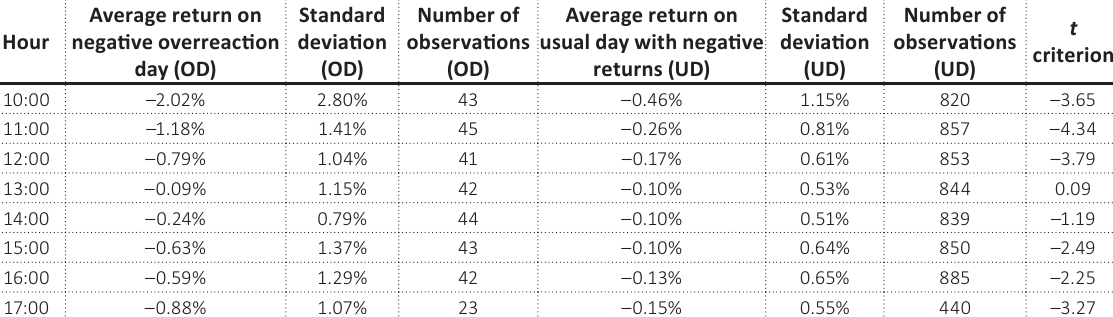
Table 2. T -test of hourly returns on overreaction and normal days: the case of negative overreactions, UX-C